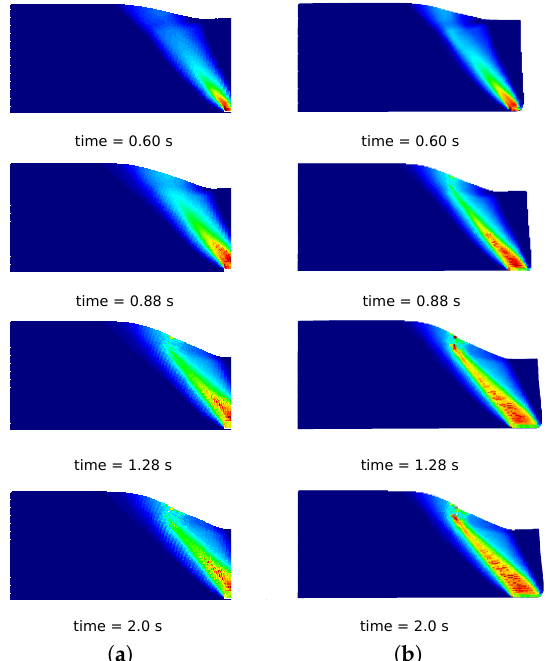
Figure 12. Soil column collapse. Distribution of equivalent plastic strains for different representative time instants in the GMM-MLS results. ( a ) Mesh 1; ( b ) Mesh 2.